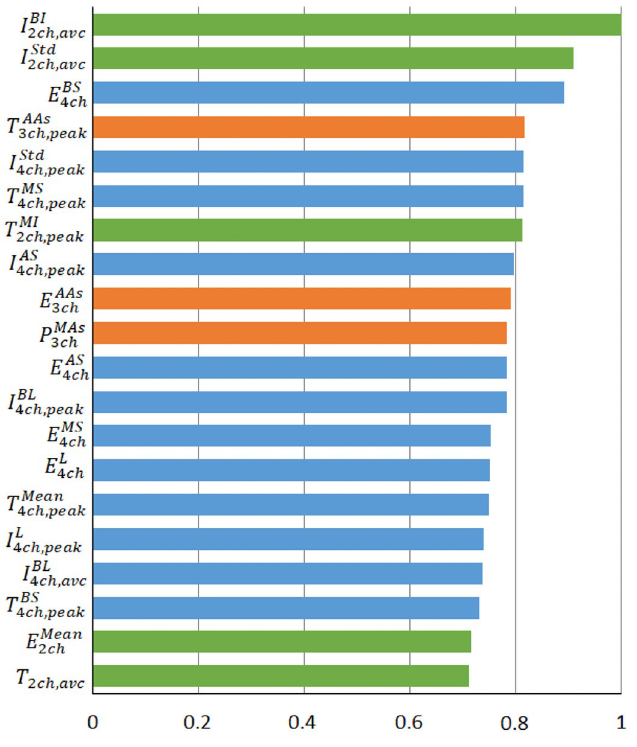
Fig 4. 20 most important features obtained from the OOB analysis (blue: 4ch, orange: 3ch, and green: 2ch).